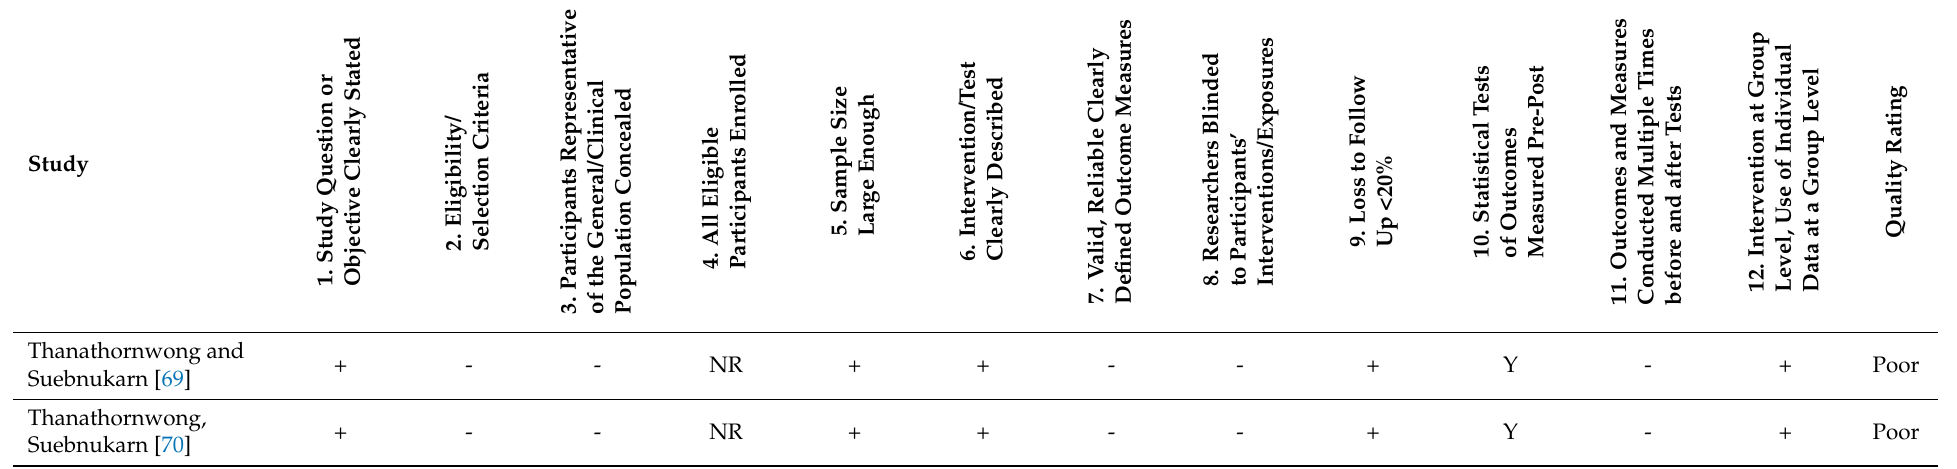
Table 7. Risk-of-bias evaluation for pre-post study designs ( n = 2) using the National Institutes of Health risk-of-bias tool for before–after (pre-post) studies with no control group.